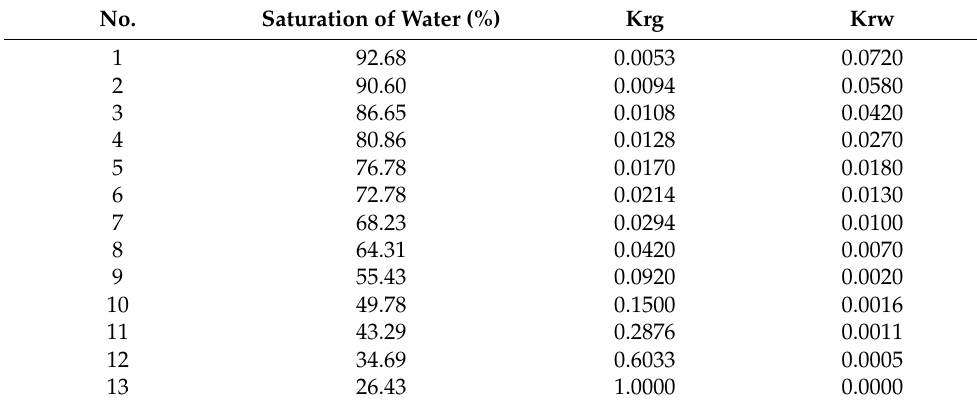
Table A6. The relative permeabilities of No.2 sandstone sample.